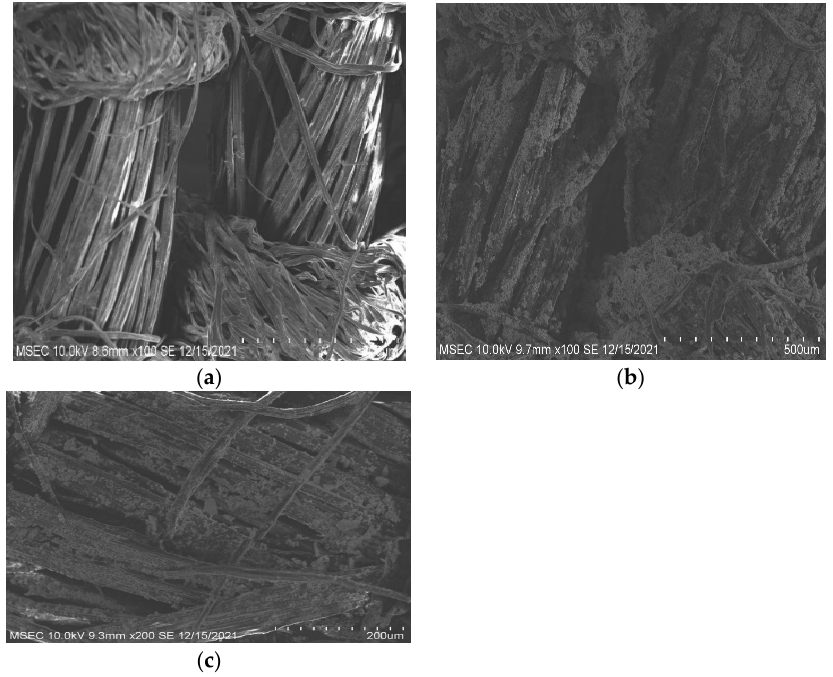
Figure 5. ( a ) SEM image of uncoated sisal fiber; ( b ) SEM image of zinc oxide-coated sisal fiber; ( c ) SEM image of iron oxide-coated sisal fiber.